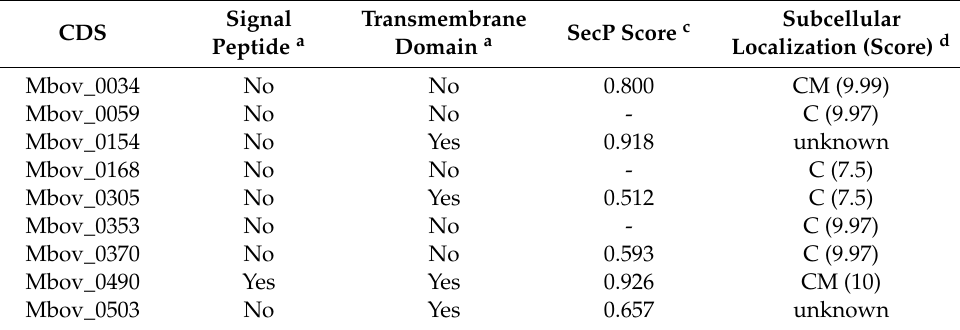
Table 3. Predicted subcellular localization of selected M. bovis CDS products.